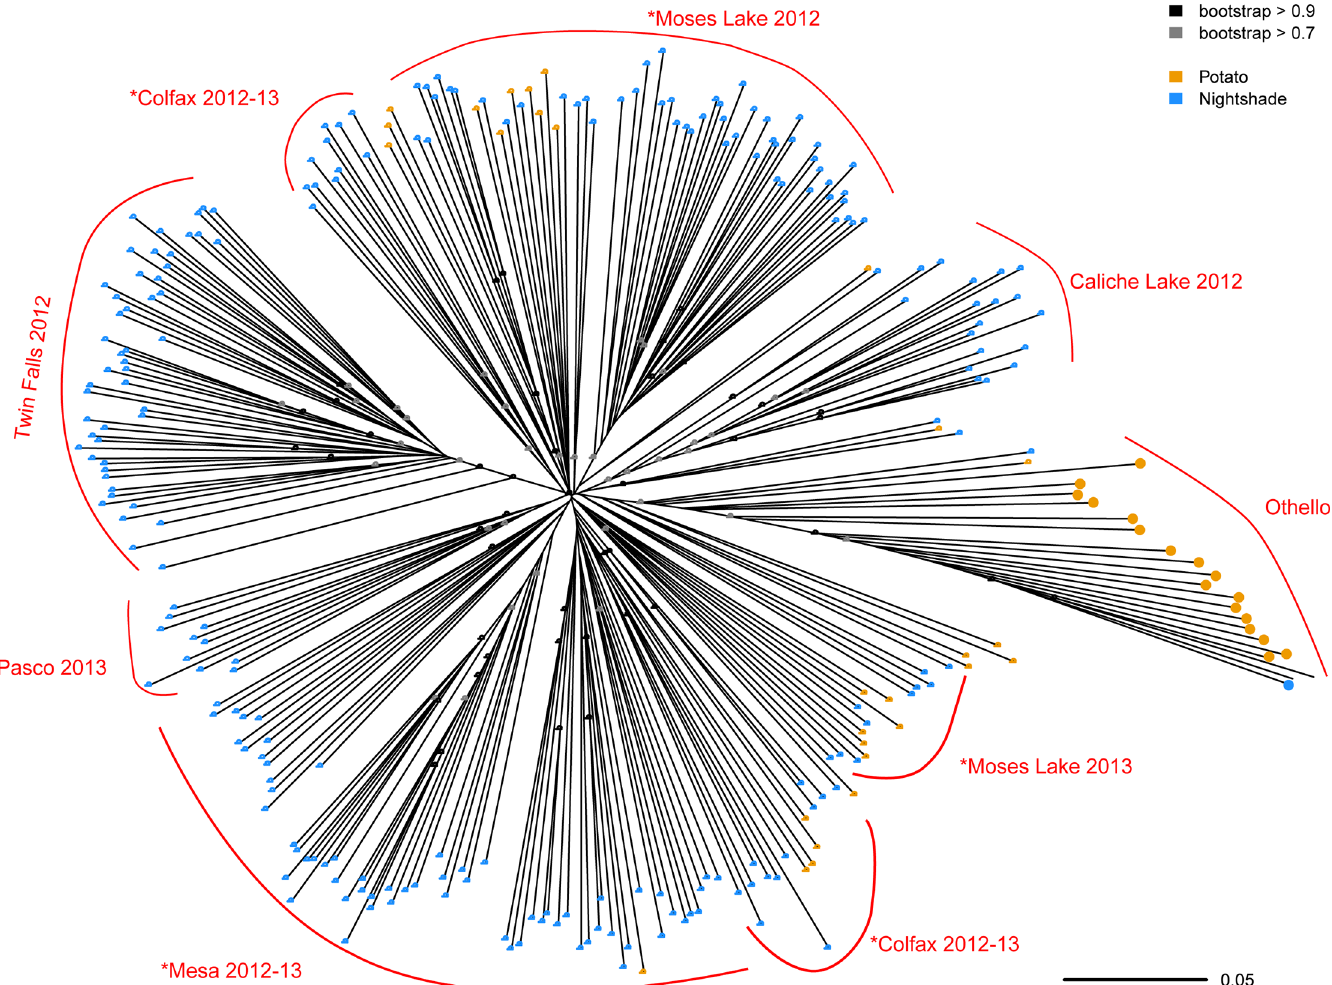
Fig 2. Unrooted neighbor-joining tree for potato psyllids collected from bittersweet nightshade patches (blue circles) or potato fields (yellow circles). The neighbor-joiningtree was constructed using proportionof shared alleles.Psyllids from Potato-ML and Potato-Patterson were not labeledas they intermixed with psyllidsfrom nightshade sites. An asterisk ( * ) indicatesthree nightshadelocationswith samples spanning two years. Samples with enlargedcircles were groupedinto a genetically distinct group in ADMIXTURE (shown in purplebars in Fig 3).